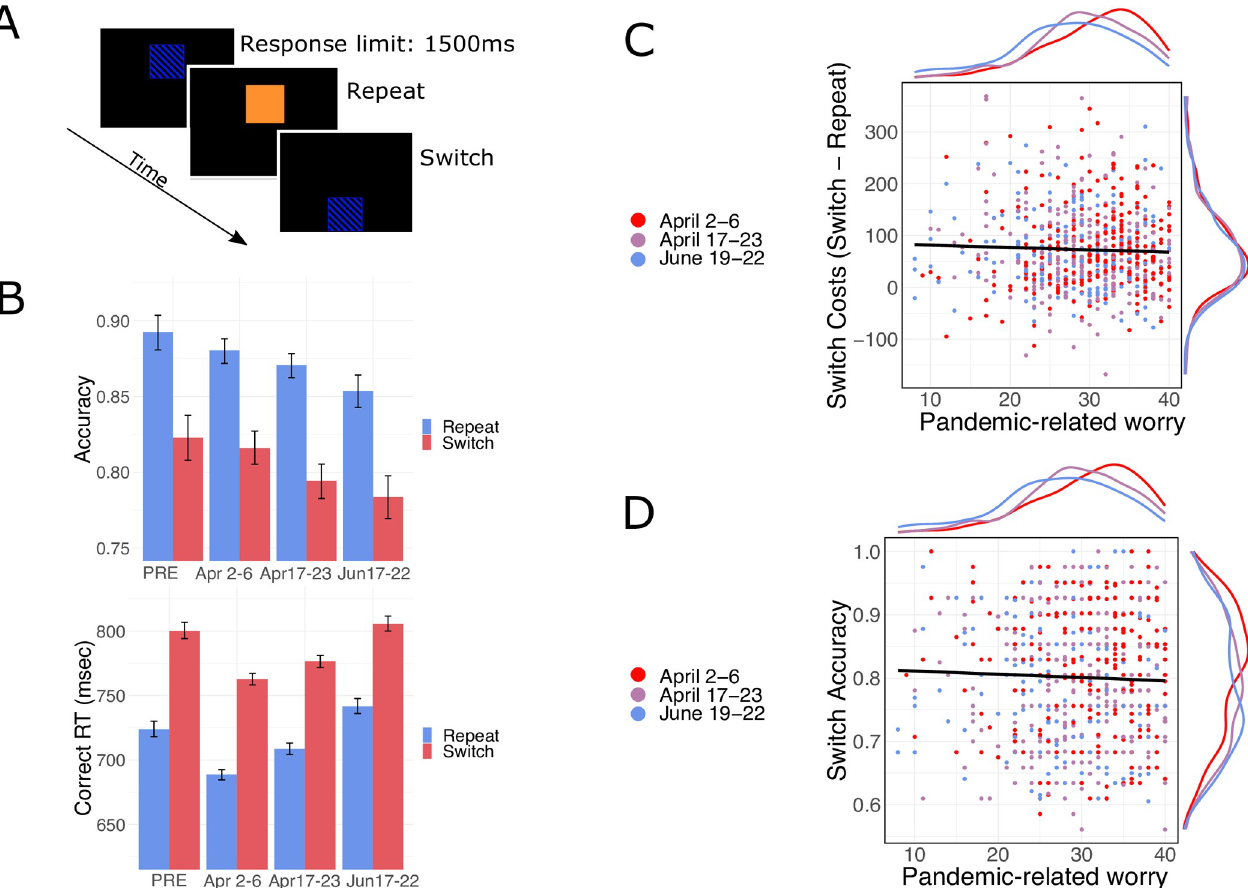
Fig 3. Participants’ performance on the Task-Switching paradigm. A. Schematic of task-switching paradigm. B. Accuracy (top; p’s < .05) but not response- times (bottom) decreased by wave (p’s � .05); variables plotted with 95% bootstrapped confidence interval. C. There was no observed relationship observed between FCQ scores and switch costs expressed in RT ( β = -0.0005, CI = [-0.0142, 0.0132], p = .946); here, plotted with marginal distributions for the ordinate and abscissa and D. There was no observed relationship between FCQ scores and switch trial accuracy ( β = -0.0385, CI = [-0.0865, 0.0096], p = .117); again, plotted with marginal distributions for the ordinate and